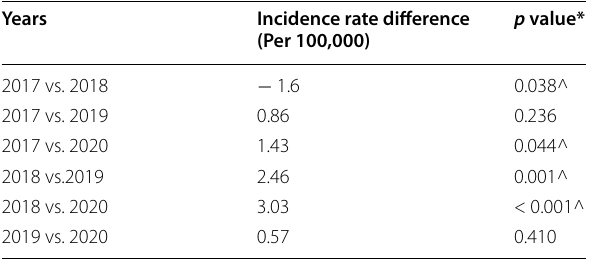
Table 1 Tuberculosis incidence rate difference in Assiut